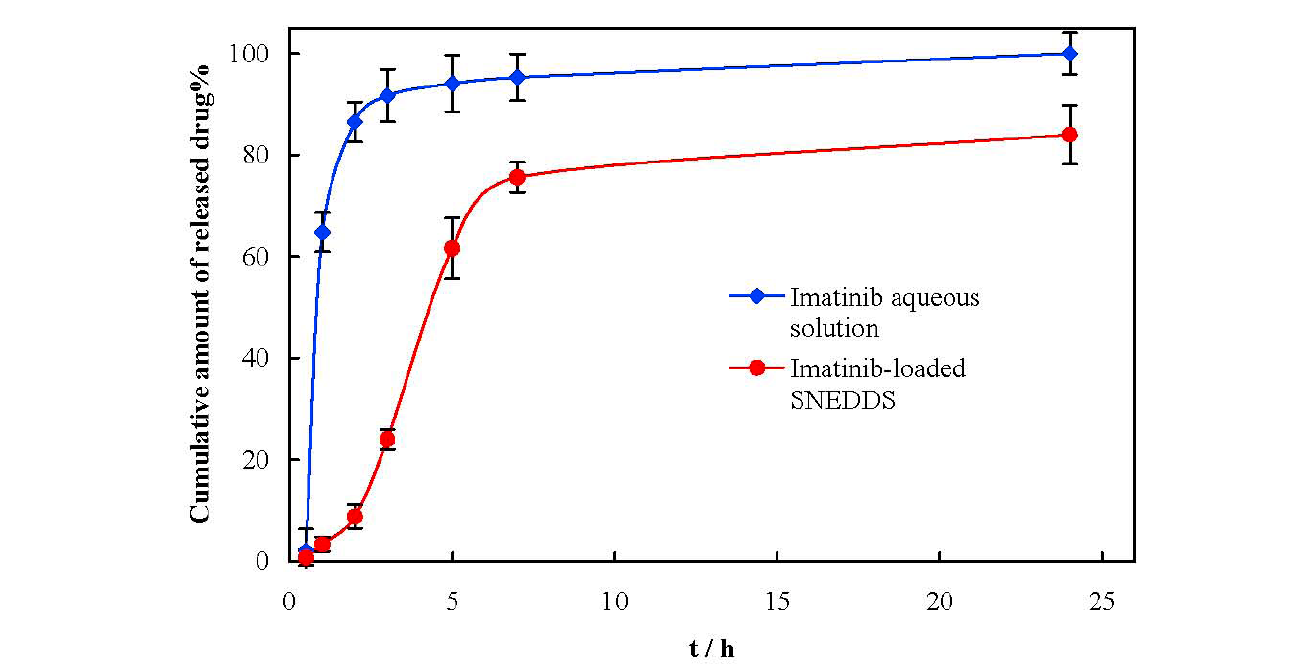
Figure 2 - A calibration curve for imatinib quanitiation by HPLC.